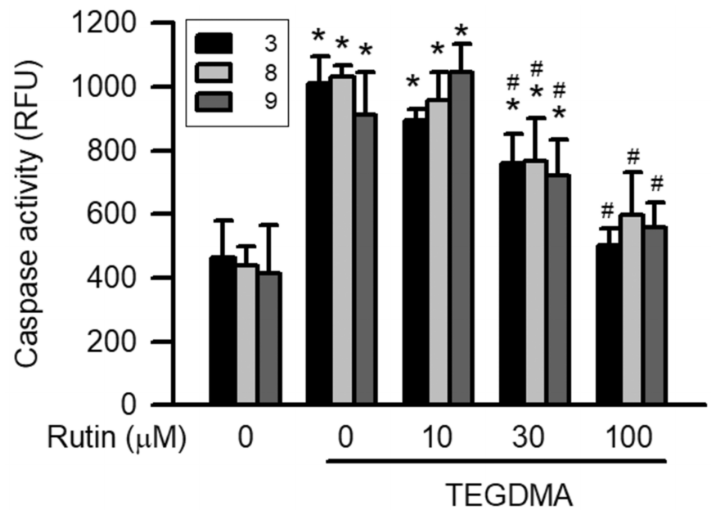
Figure 4. Effect of rutin on TEGDMA-induced caspases activities in RAW264.7 macrophages. Values are expressed as mean ± S.D. of three times per group. * Represents significant difference between the indicated and control groups, p < 0.05. # Means significant difference between the indicated and TEGDMA groups, p < 0.05.